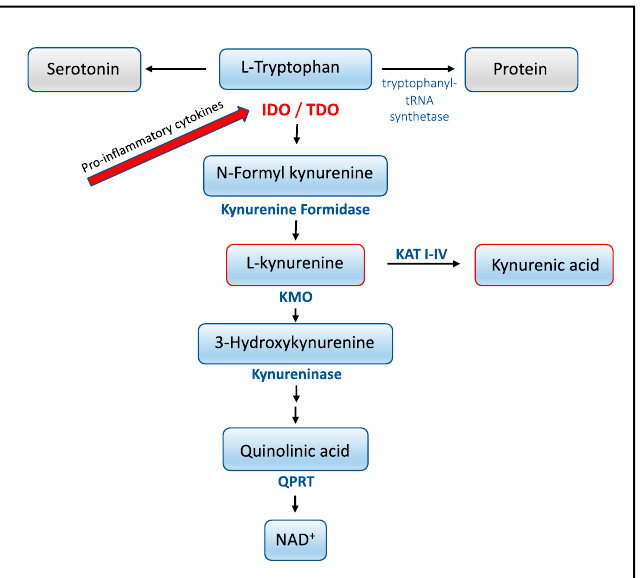
Figure 1. Schematic overview of the kynurenine pathway. The first and rate-limiting step is cata- lyzed by indoleamine 2,3-dioxygenase (IDO1 and 2) or by tryptophan 2,3-dioxygenase (TDO2) that transform tryptophan to N -formyl kynurenine. The second enzyme in the pathway kynurenine formamidase produces L -kynurenine that could enter different possible branches, depending on cell-type or environmental context, to form various metabolites such as kynurenic acid (KYNA) by kynurenine aminotransferases (KAT I-IV) or quinolinic acid via kynurenine mono oxidase (KMO). Pathways represented by interrupted arrows involve several metabolites and enzymatic reactions.